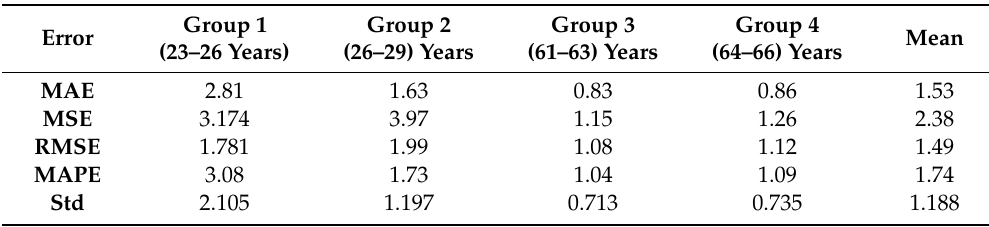
Table 3. Results of the error